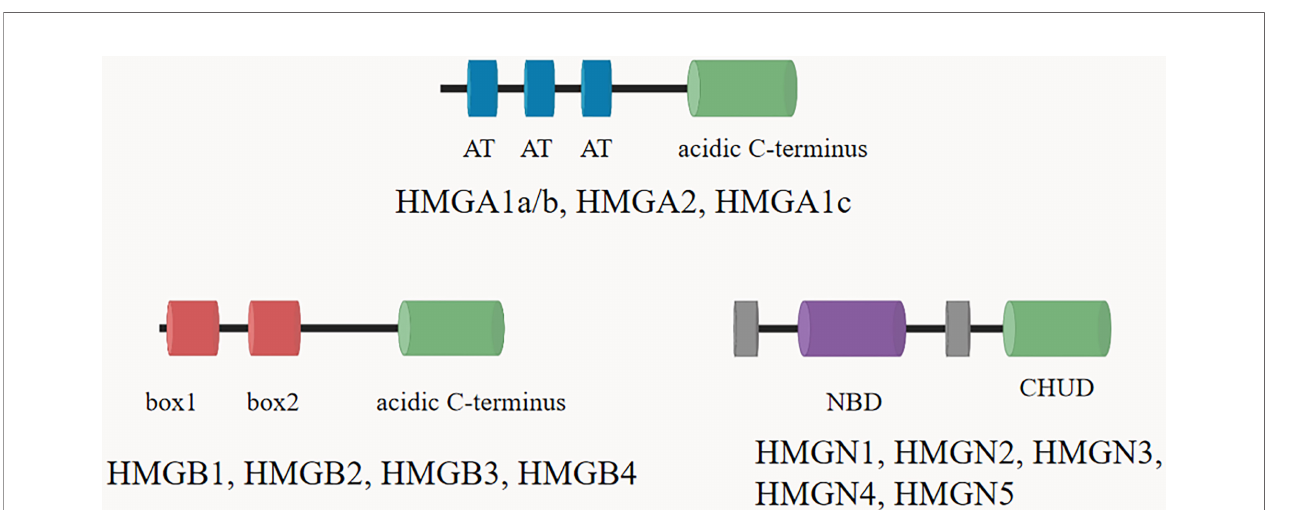
FIGURE 1 | The structural features of the HMGs. Family members are listed above each diagram. All HMGAs contain three AT hooks and an acidic C-terminal part, except HMGA1c, which contains only two hooks. Each of the three members of the HMGB family contains two HMG boxes and an extended acidic C-terminus. The HMGN proteins are characterized by a positively charged nucleosomal binding domain (NBD) and a negatively charged C-terminal region named chromatin unfolding domain